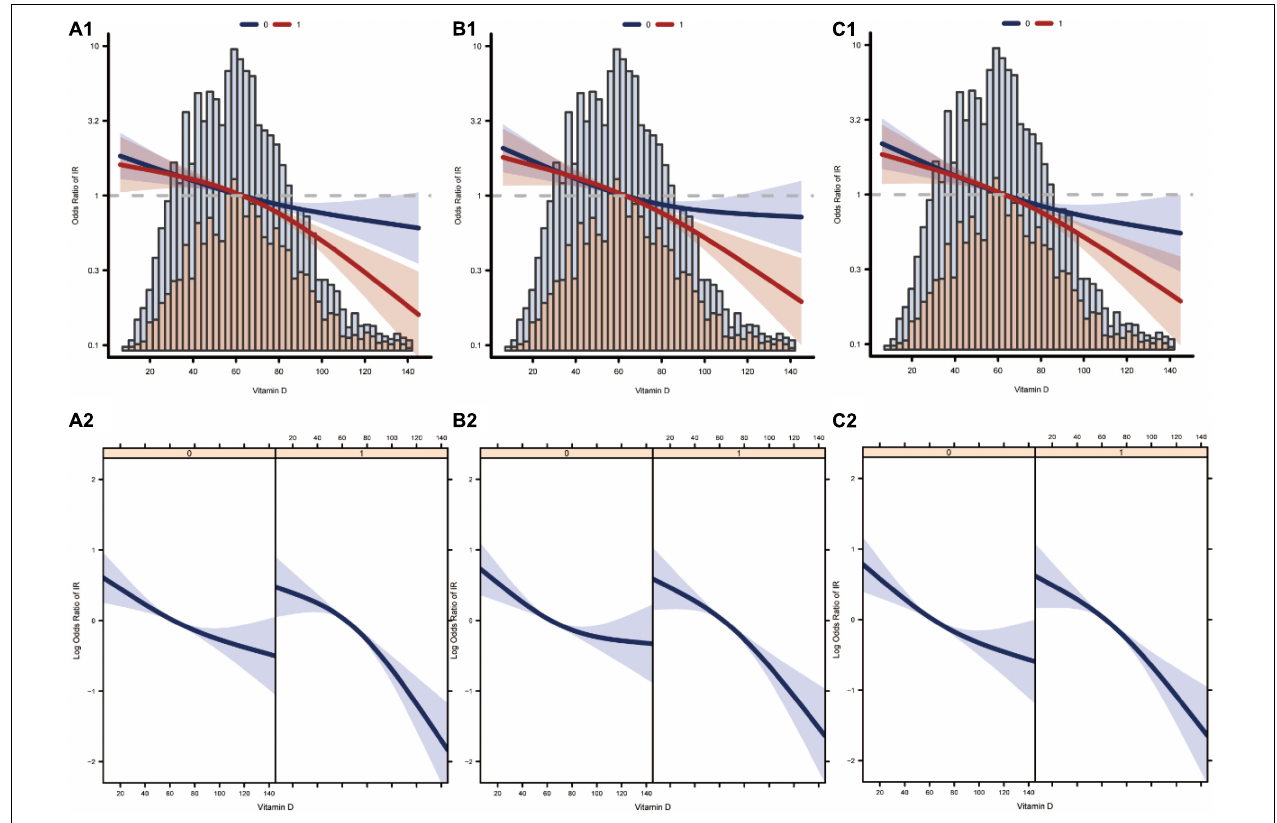
FIGURE 4 | Curve fitting of vitamin D levels and the risk of developing insulin resistance. (A1,A2) Are association between vitamin D and insulin resistance at different levels of dietary magnesium intake after adjustment by model 1. (B1,B2) Are association between vitamin D and insulin resistance at different levels of dietary magnesium intake after adjustment by model 2. (C1,C2) Are association between vitamin D and insulin resistance at different levels of dietary magnesium intake after adjustment by model 3 (0: low dietary magnesium intake group, 1: high dietary magnesium intake